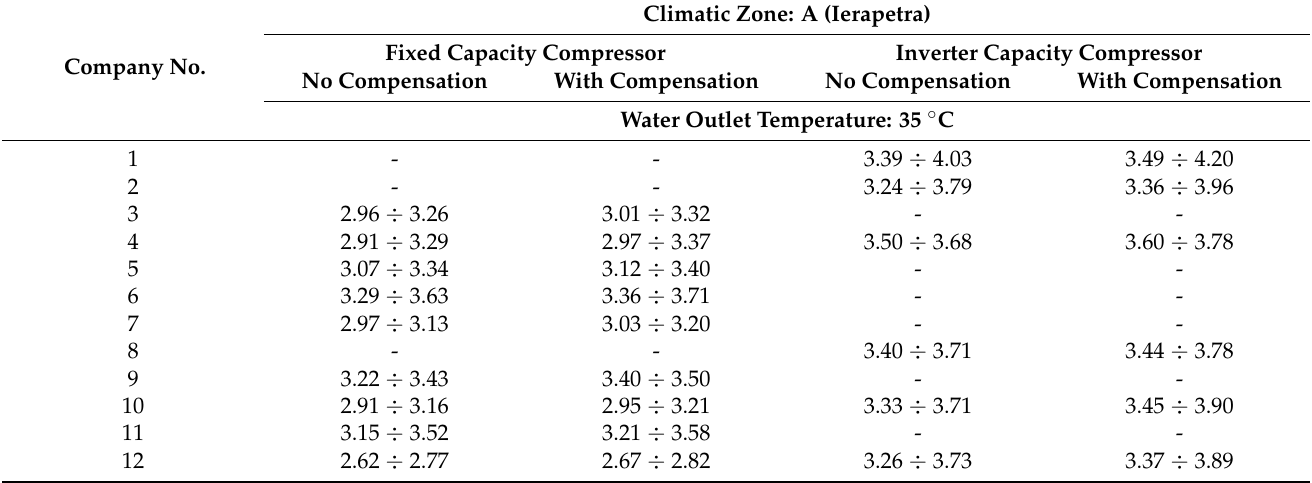
Table 4. AWHPs’ SCOP per company: Ierapetra, water outlet temperature 35, 45, and 55 ◦ C. Climatic Zone: A Company No.